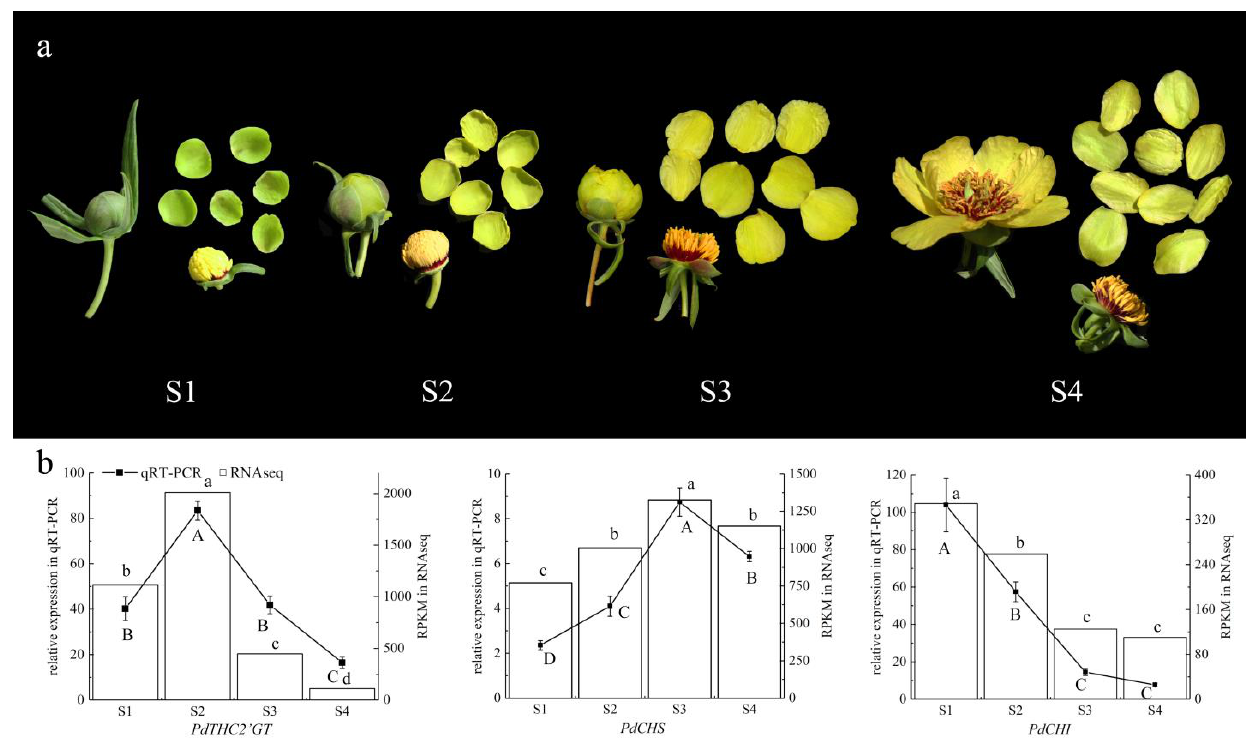
Figure 4. The expression patterns of PdTHC2 (cid:48) GT, PdCHS, and PdCHI . ( a ) Four blooming periods of P. delavayi var. lutea flowers. S1: Unpigmented tight bud, the petals are completely green. S2: Slightly pigmented soft bud, the petals begin to change from green to yellow. S3: Initially opened flower, the stamens are not visible, and the petals have completely turned yellow. S4: Fully opened flower, the stamens are completely exposed, and the petals are a lighter yellow than those in S3. ( b ) Comparison of RNA-seq and qRT–PCR analyses for PdTHC2 (cid:48) GT , PdCHS, and PdCHI . The different lowercase letters indicate significant differences in RNAseq among the different sampling points, the different capital letters indicate significant differences in qRT-PCR among the different sampling points ( p < 0.05), and the error bars indicate the standard deviations.